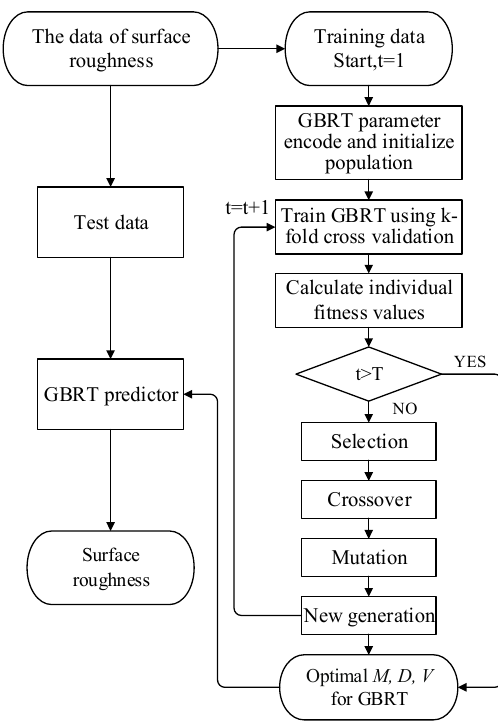
Figure 5. GA-GBRT model development flow chart. Appl. Sci. 2019 , 9 , x FOR PEER REVIEW